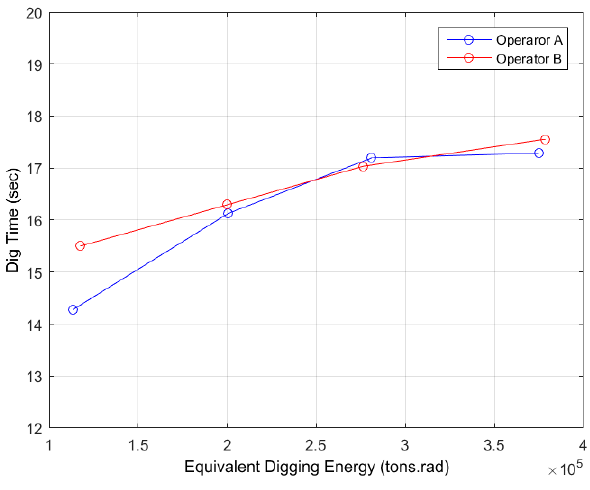
Figure 11. Average dig time for different digging energy classes.